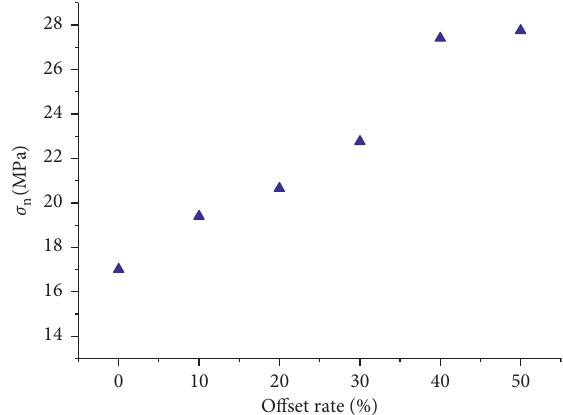
Figure 4: Effect of the offset rate on the nominal strength. 0.91.01.11.21.31.41.51.61.7 β = 1.36182 x + 0.9777 R 2 = 0.95264 β